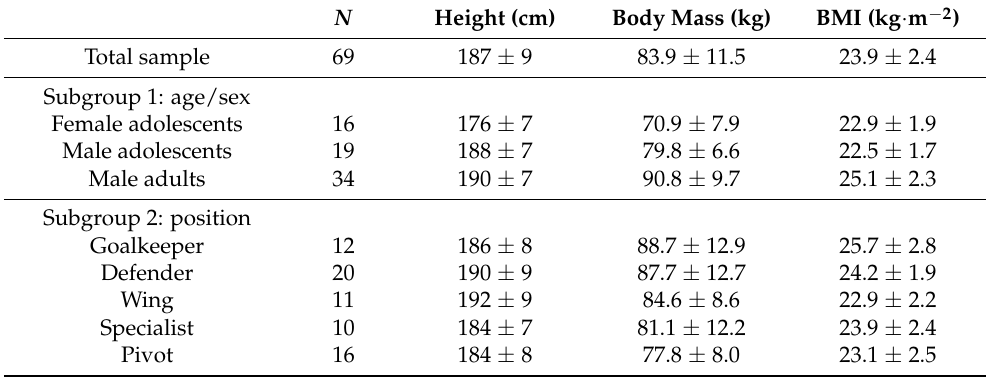
Table 1. Distribution and anthropometric characteristics of the total sample, and by group and playing